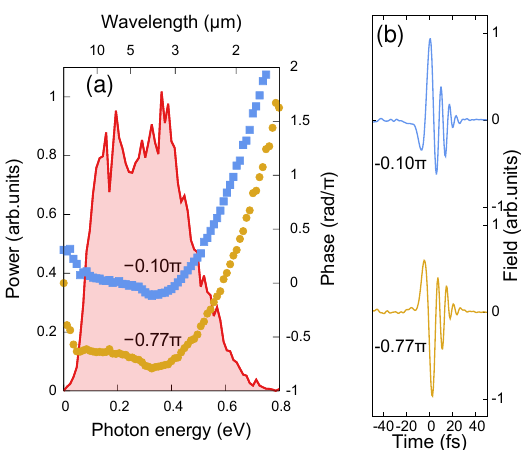
Figure 1. (a) Power spectrum and absolute spectral phases. (b) Retrieved waveforms of the MIR pulses.